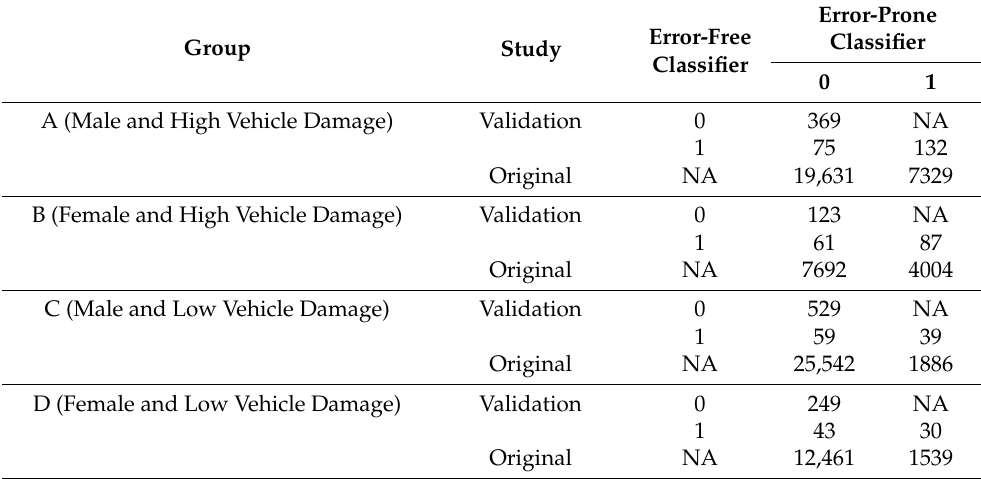
Table 3. Vehicle accident